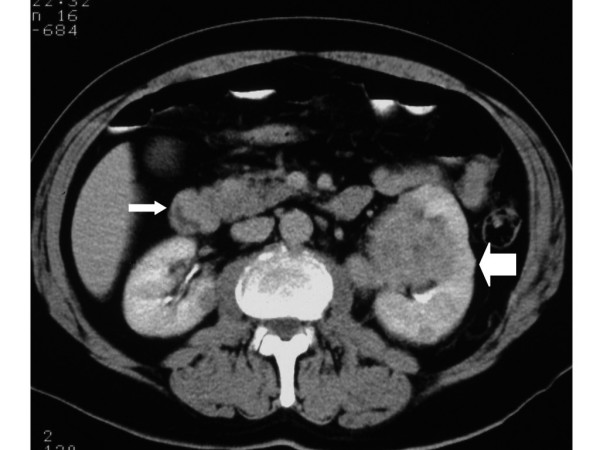
Abdominal CT scan. Abdominal CT scan demonstrating a left-sided renal tumour (thick arrow) and a polypoidal mass in the wall of the second part of the duodenum (thin arrow) arising from the pancreas (not shown).